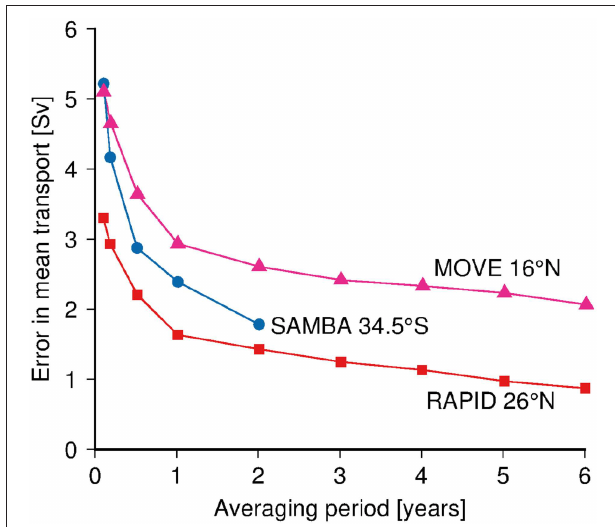
FIGURE 5 | Uncertainty on the estimate of the mean AMOC based on averaging for a certain number of years of the AMOC time series at RAPID 26 ◦ N (red squares), MOVE 16 ◦ N (magenta triangles) and SAMBA 34.5 ◦ S (blue circles). Note that the limit in the error will be bounded below by the intrinsic variability in the time series, which is higher at 16 ◦ N than the other two latitudes (see Table 1